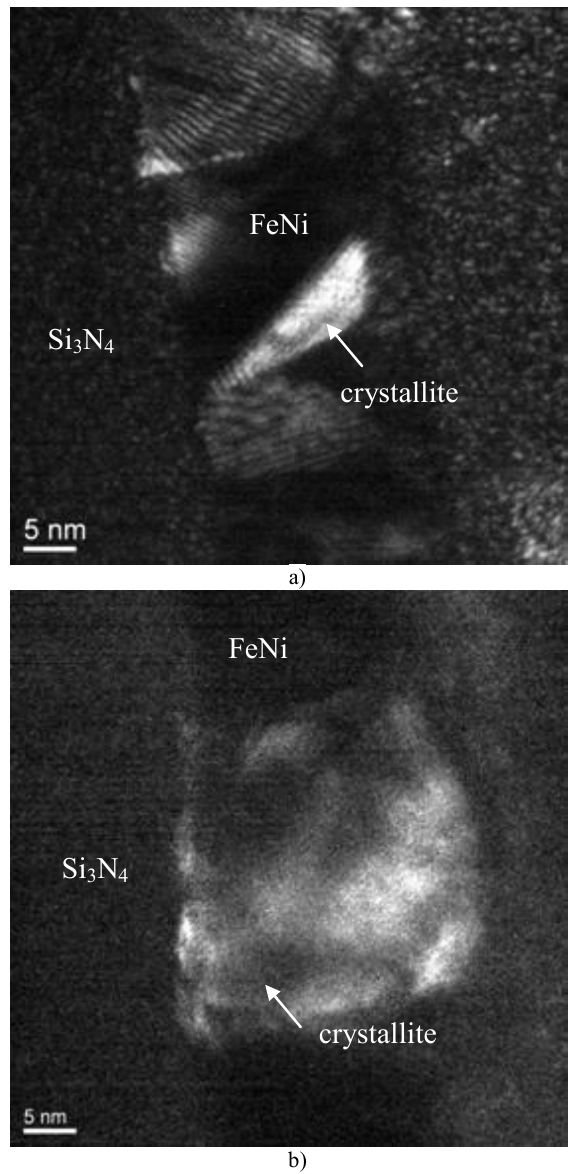
Fig. 3. The surface image of the permalloy films at different deposition temperatures taken with AFM AIST-NT Smart SPM-1000. a) the substrate temperature during the deposition was 270 °C, Ra is equal to 0.16 nm, and b) the substrate temperature during the deposition was 390 °C, Ra is equal to 0.97